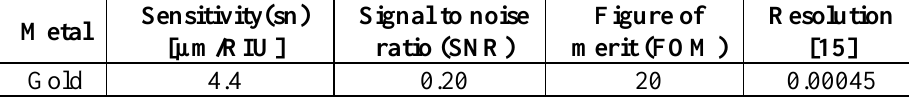
Table 1: Experimental performance parameters of the multi-layer based sensor.